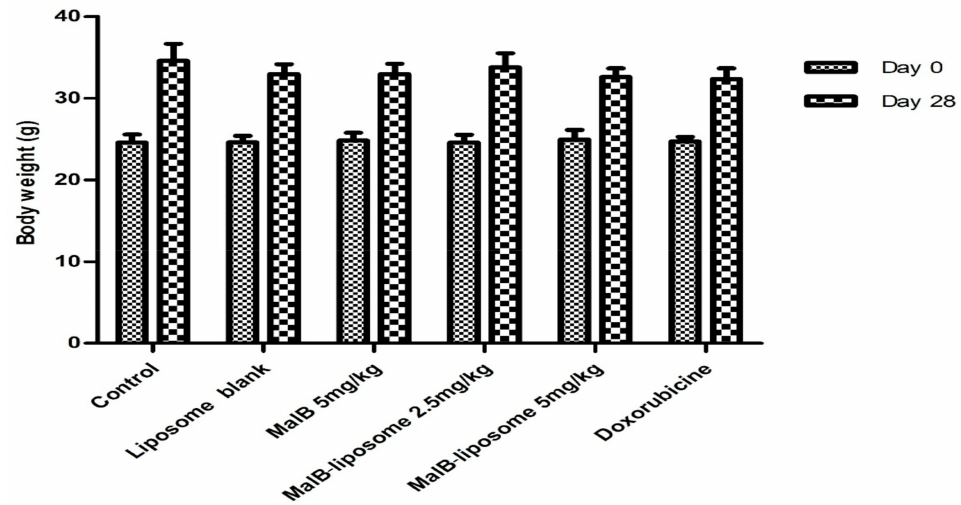
Figure 5. E ff ects of malB or malB-nanoliposomes on body weight of BALB / c mice harboring a malignant tumor induced by LLC cells ( n = 6 ). Error bars represent standard error of the mean (SEM).